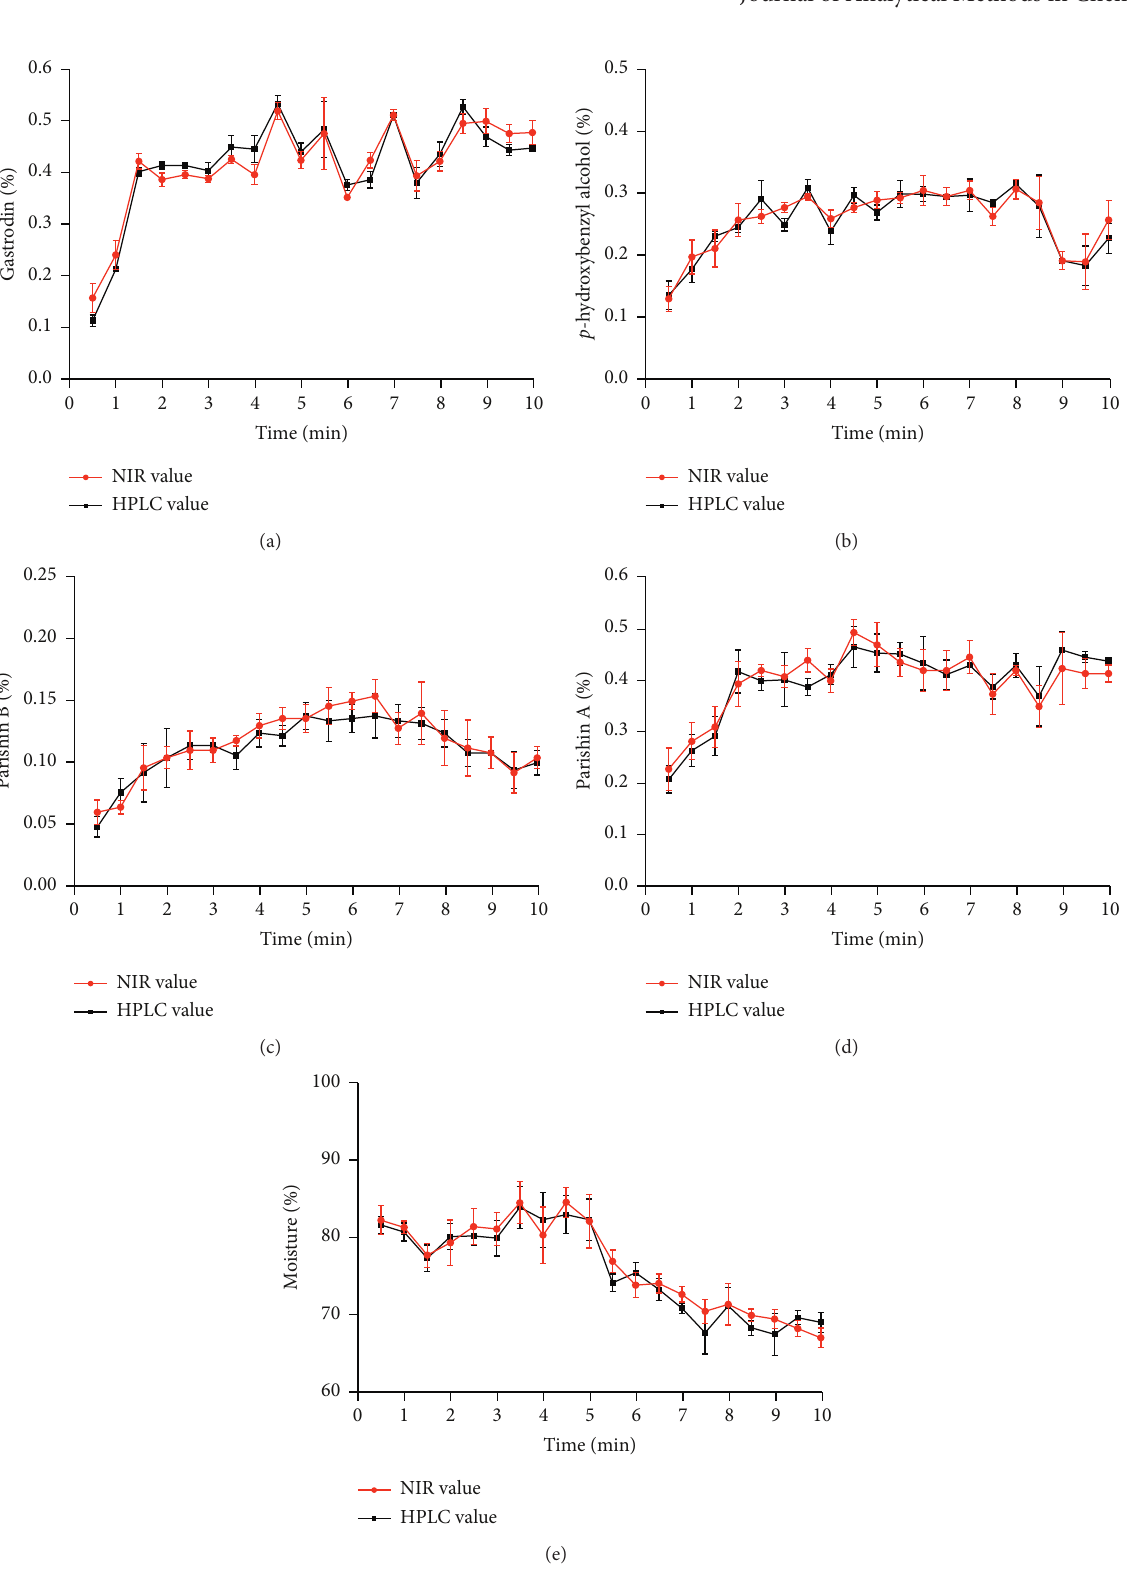
Figure 9: Comparison of the online NIR prediction values with the reference values of the steaming process of the test